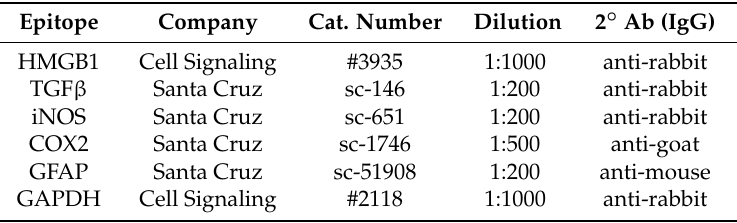
Table 3. List of antibodies used in the current study.